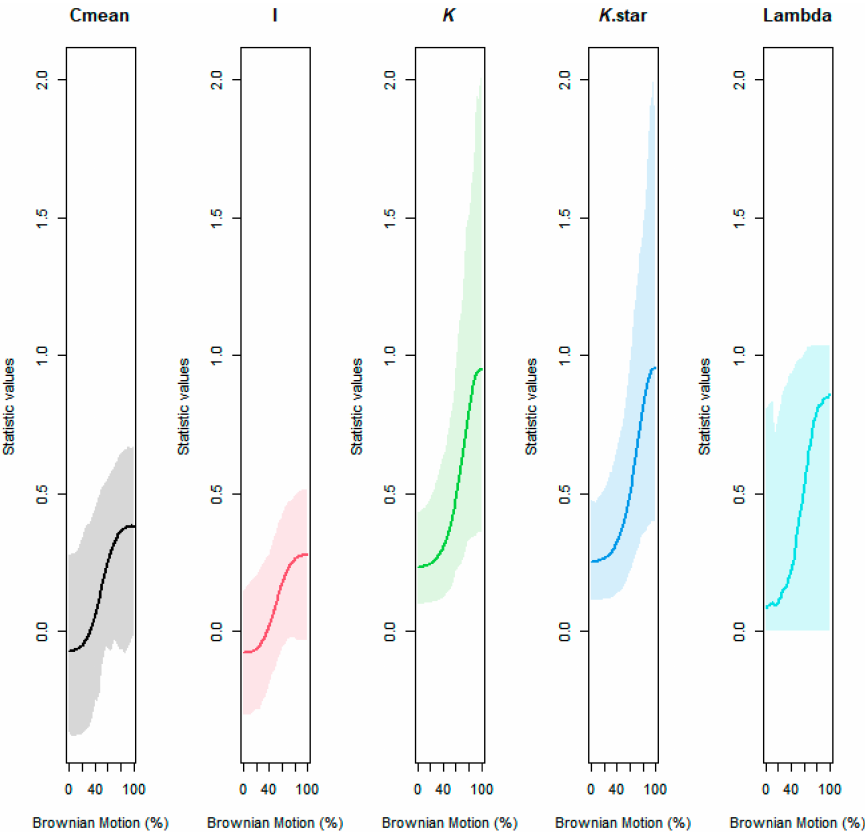
Figure A4. Assessing the behavior of phylogenetic signal via Brownian motion influence gradient and 95%